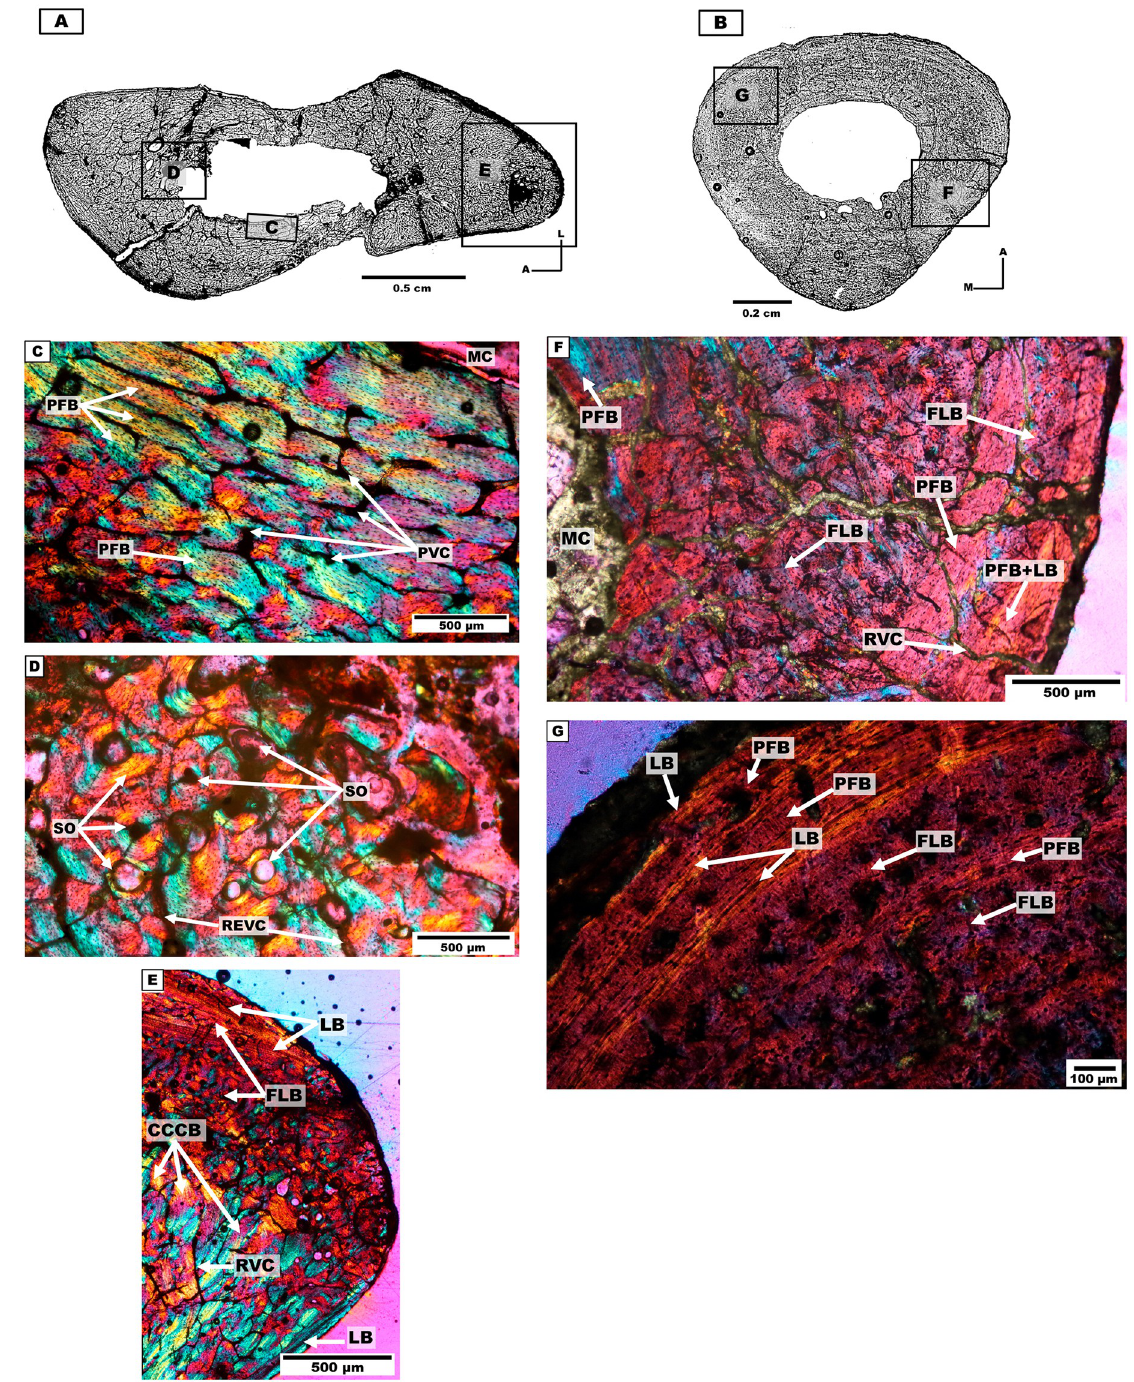
Fig 6. Ulnar and metacarpal III cross-sections of the mesotheriine notoungulate Caraguatypotherium munozi from middle Miocene of Caragua, Huaylas formation. (A) Ulna cross-section for individual 2 (GEOUACH.HS.UD.1); (B) Metacarpal III cross-section for individual 1 (GEOUACH.HS.MTC.2); (C) Intracortical region, presence of PFB with PVC (GEOUACH.HS.UD.1); (D) SO, in the endocortical region (GEOUACH.HS.UD.1); (E) Posterior area of the section, presence of CCCB, LB and PFB are identified. Vascularization dominated by RVC (GEOUACH.HS.UD.1); (F) PFB in the endocortical region, FLB in the intracortical region PFB and LB in the pericortical region GEOUACH.HS.MTC.2); (G) In the intracortical region and pericortical region intercalation of LB with PFB (GEOUACH.HS.MTC.2). For abbreviations refer to Fig